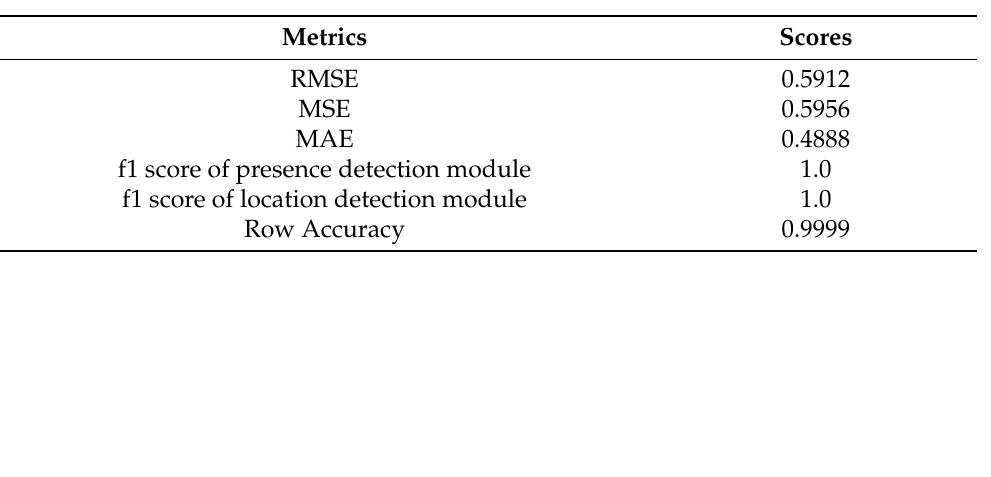
Table 9. Performance of Proposed Algorithm trained on Minutely